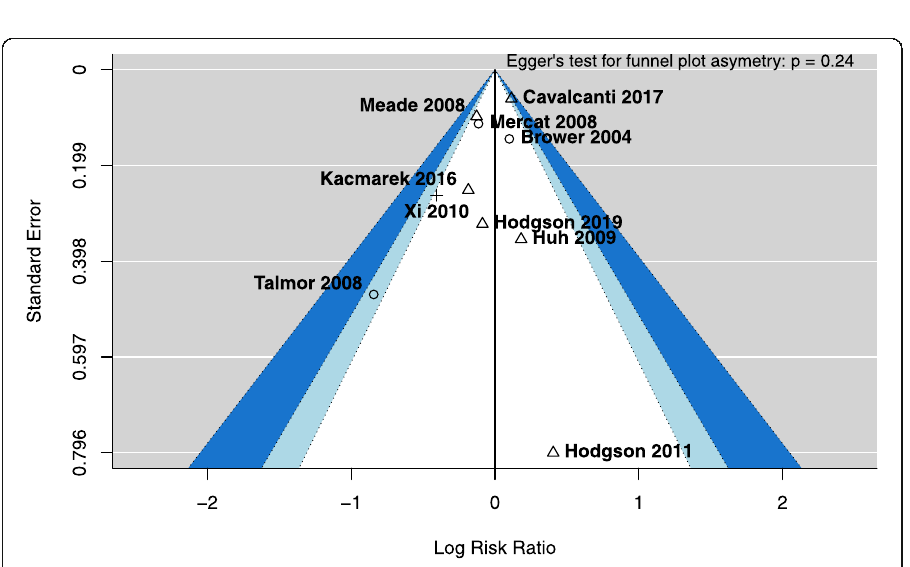
Fig. 3 Funnel plot for mortality (collapsed at 28 days, ICU discharge, hospital discharge or 60 days). Shapes represent different interventions: higher PEEP alone (circle), recruitment manoeuvres alone (cross) or both (triangle). Dotted lines represent the 90%, 95% and 99% pseudo confidence interval regions. ICU, intensive care unit; PEEP, positive end-expiratory